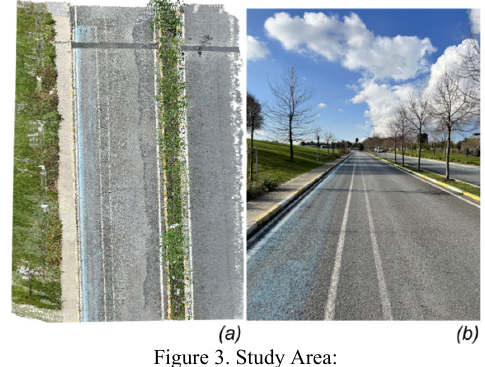
Figure 3. Study Area: 3D view of the point cloud (a), 2D image